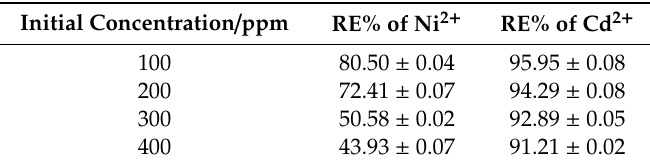
Table 4. Removal e ffi ciencies (RE %) of hematite nanoparticles at di ff erent concentrations of Ni 2 + and Table 4. Removal efficiencies (RE %) of hematite nanoparticles at different concentrations of Ni 2+ and Cd 2 + Cd 2+ ions.